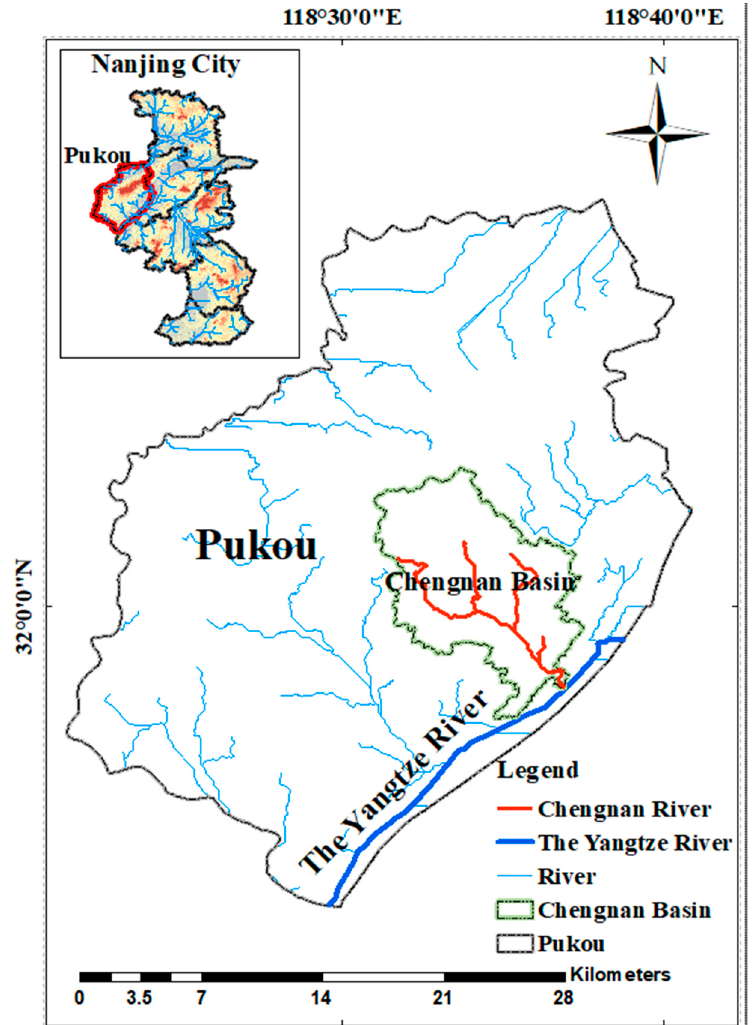
Figure 1. The Location of the Chengnan River.